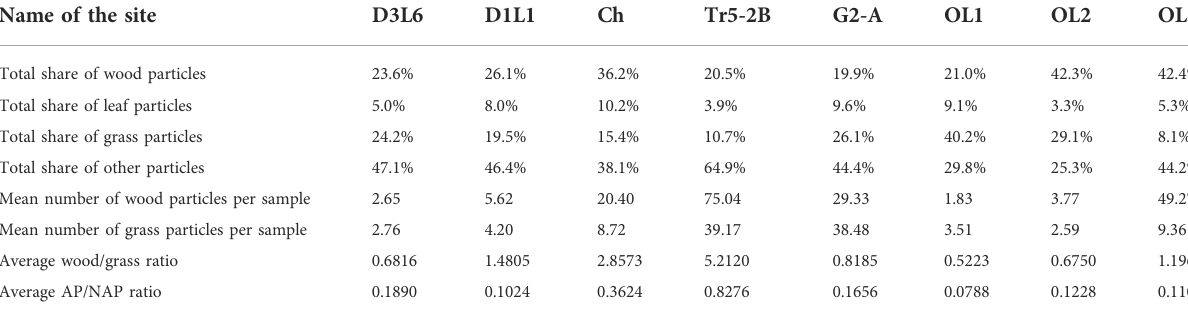
TABLE 2 Statistics for macro-charcoal morphotype results at the Altai Tavan Bogd NP (D3L6-G2A) and Tarvagatai Nuruu NP (OL1 –